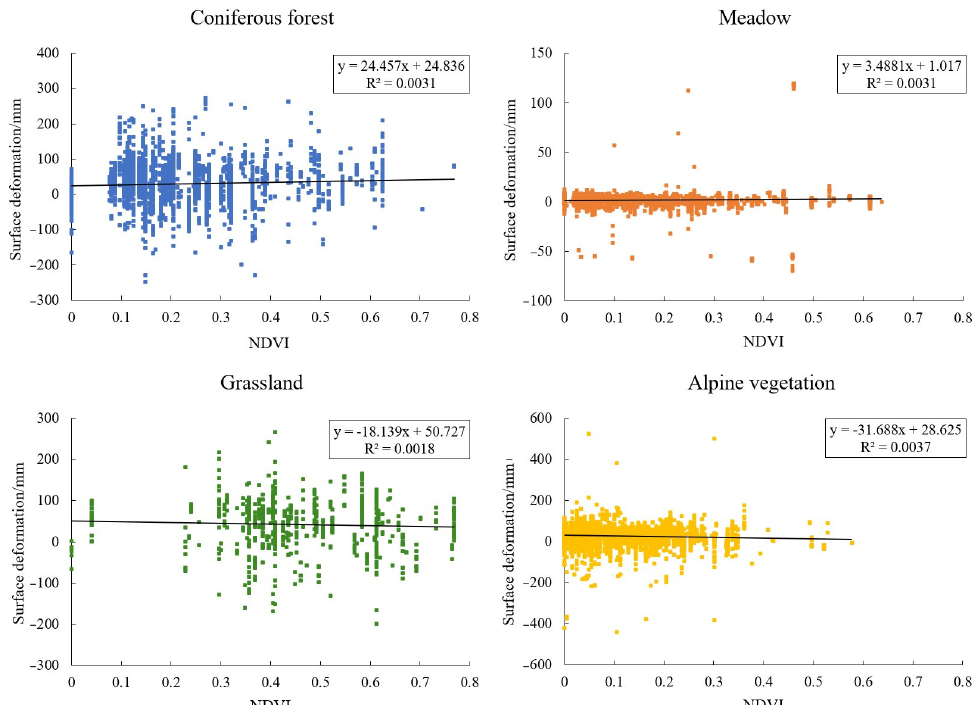
Figure 13. Correlation between surface deformation and NDVI by vegetation cover.